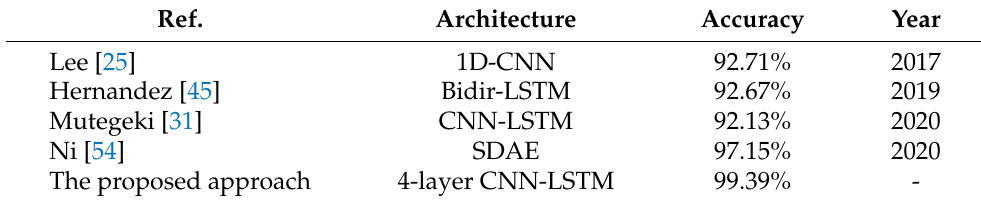
Table 13. Performance comparison